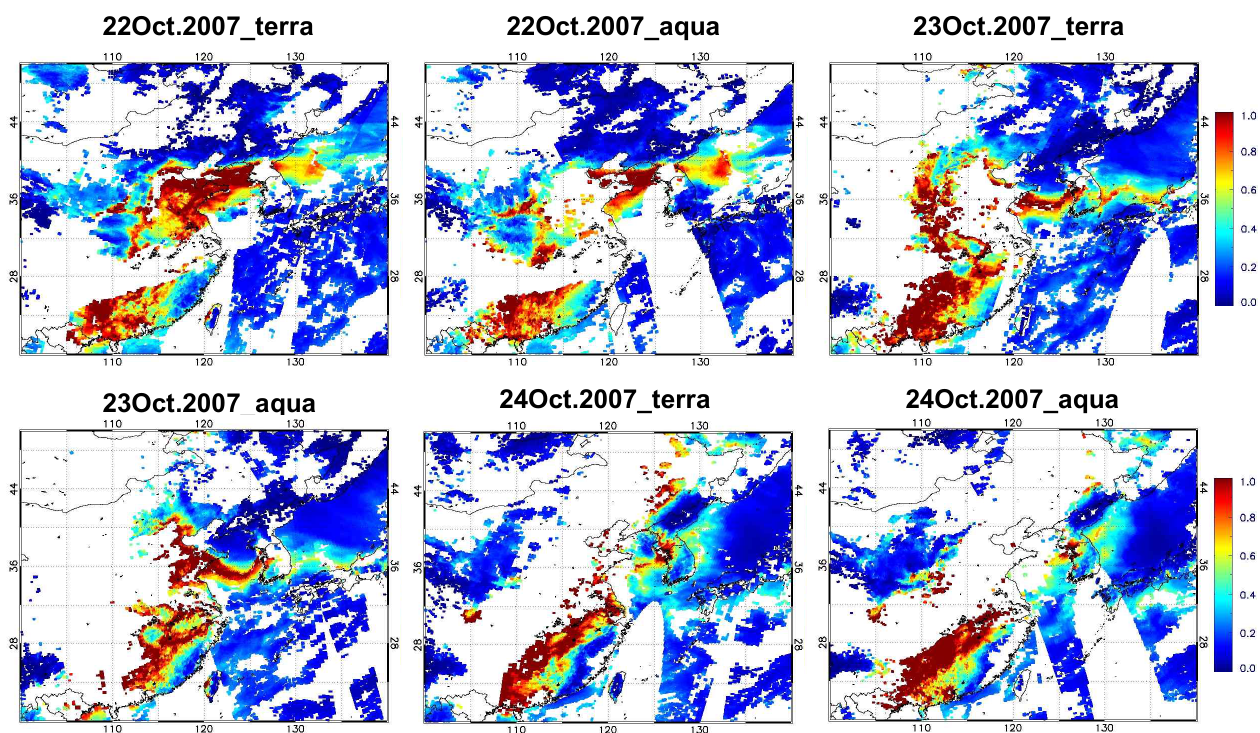
Fig. 15. Spatial distribution of AOT over Northeast Asia during the selected days of LRT period (22–24 October 2007).